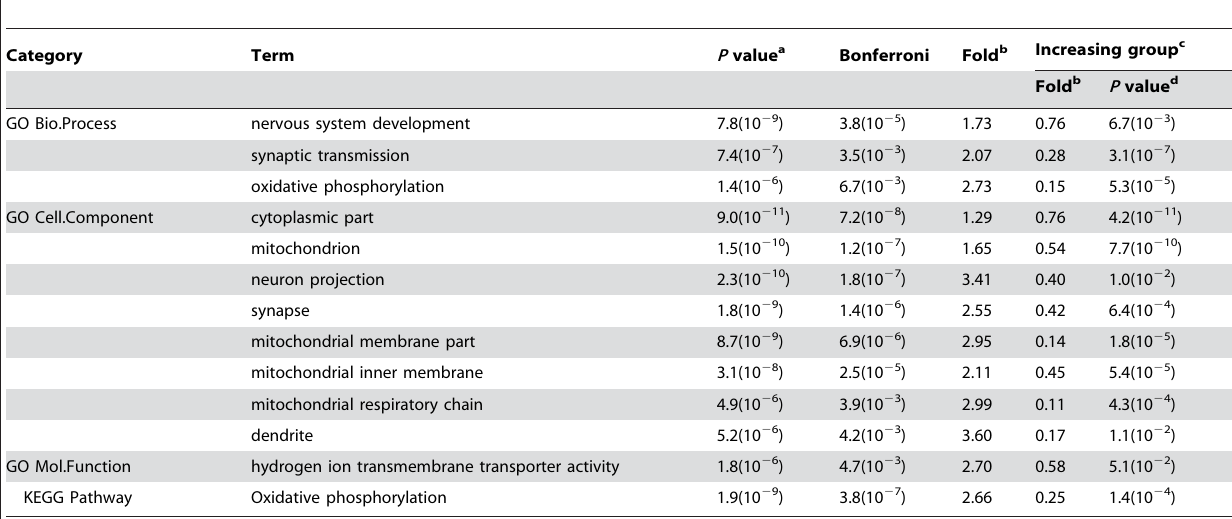
Table 3. Terms in the Gene Ontology and KEGG pathway databases over-represented among genes that decreased expression with advancing age in the human brain (1,450 genes in total 13,216).